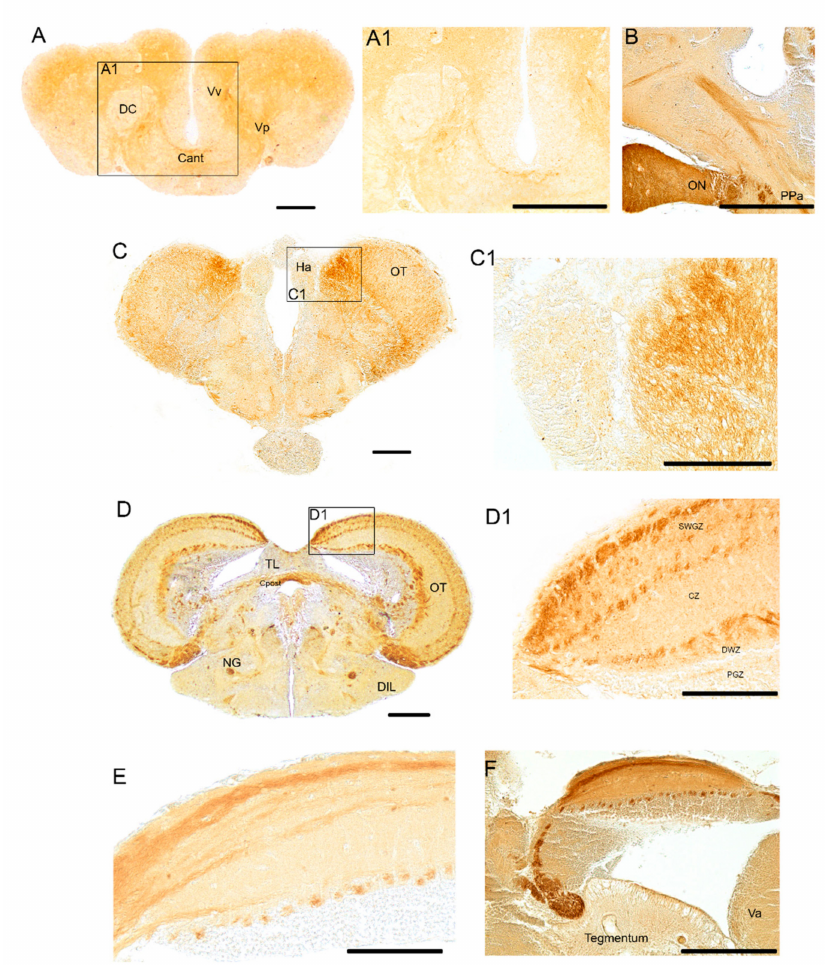
Figure 2. Forebrain and midbrain of adult N. furzeri . ( A ). Transverse section of the forebrain with numerous immunopositive fibers over the telencephalon and in the varicose fibers of the anterior commissure. ( A1 ). Higher magnification of the rectangle in A showing varicose fibers of the anterior commissure. ( B) . Sagittal section of forebrain showing a group consisting of few positive neurons in the preoptic area in the rostral diencephalon and numerous fibers projecting toward the telencephalon. ( C ). Transverse section of the pretectal region and in the most rostral part of optic tect, epithalamus, thalamus and rostral part of hypothalamus depicting numerous widespread immunopositive fibers ( C1 ). Higher magnification of the rectangle in C showing positive fibers of OT and faintly labeled cells in the ventro-lateral part of habenular nucleus. ( D ). Transverse section of caudal diencephalon / anterior midbrain displaying immunoreactivity to ChaT in fibers, displaced along the dorsal margin of longitudinal tori and in the posterior commissure; wide distribution of positive fibers in the whole posterior thalamic area / anterior midbrain tegmentum and posterior commissure. ( D1 ). Higher magnification of the rectangle in D showing immunoreactivity in fibers of the deep white zone and superficial white and gray zone of OT. ( E ). Sagittal sections showing strong immunoreactivity in fibers of the deep white zone (resembling glomeruli) and superficial white and gray zone of OT. ( F